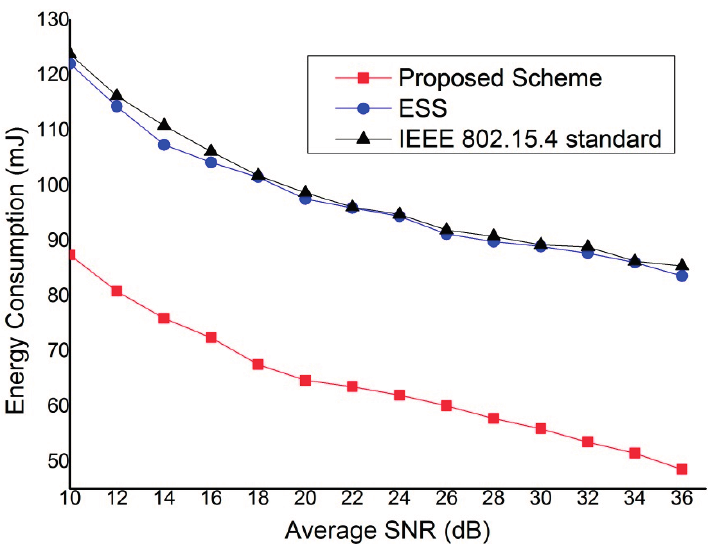
Figure 19. The energy consumption of device versus the average